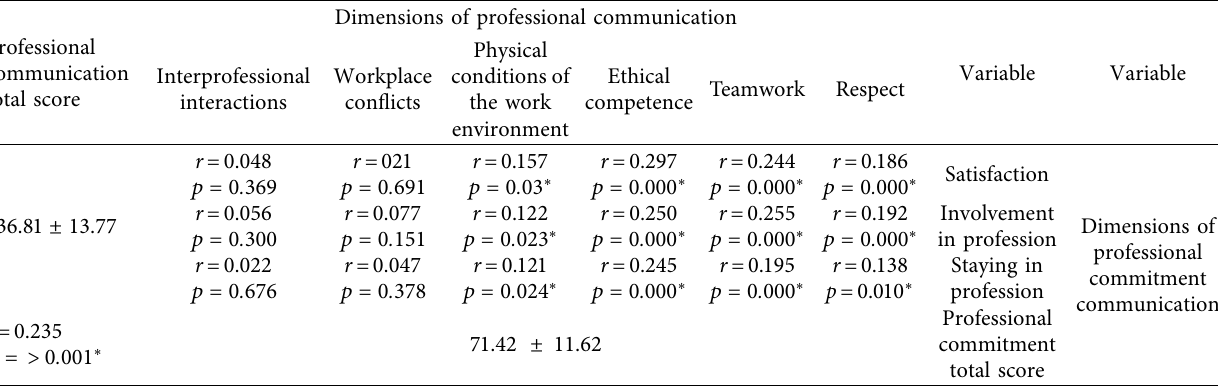
Table 3: The relationships between the dimensions of professional communication and professional commitment.